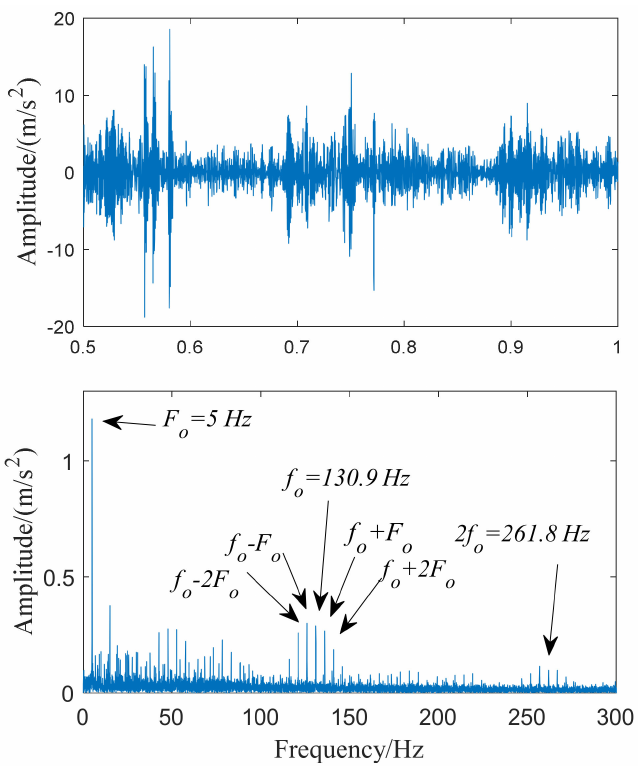
Figure 14. Time–domain signal and envelope spectrum of the OR fault (experimental). (3)